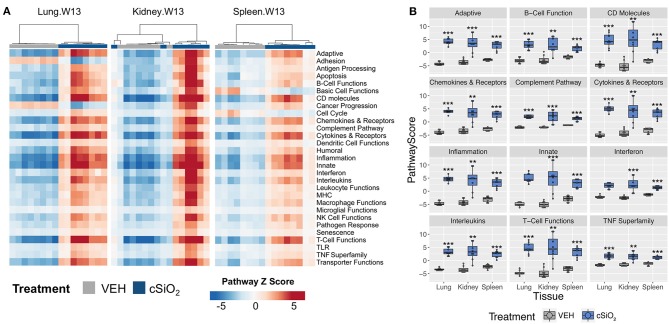
Gene expression pathway Z scores for lung, kidney or spleen tissues obtained 13 weeks post cSiO2 instillation. (A) Heatmap depicts individual pathway Z scores of each immune pathway for lung, kidney, or spleen tissues obtained from mice 13 weeks post instillation with cSiO2 (four weekly doses) or the corresponding tissue-matched vehicle (VEH) control. (B) Pathway Z scores are presented as Tukey box-plots (n = 8) for select immune pathways of interest. **p < 0.01; and ***p < 0.001 compared to time-matched vehicle control as determined by the non-parametric Wilcoxon test.